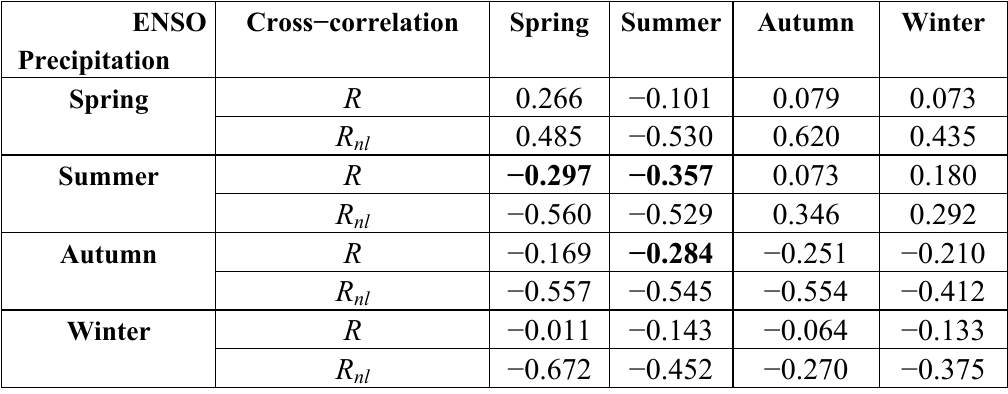
Table 2. Linear and nonlinear cross-correlations (ENSO vs.